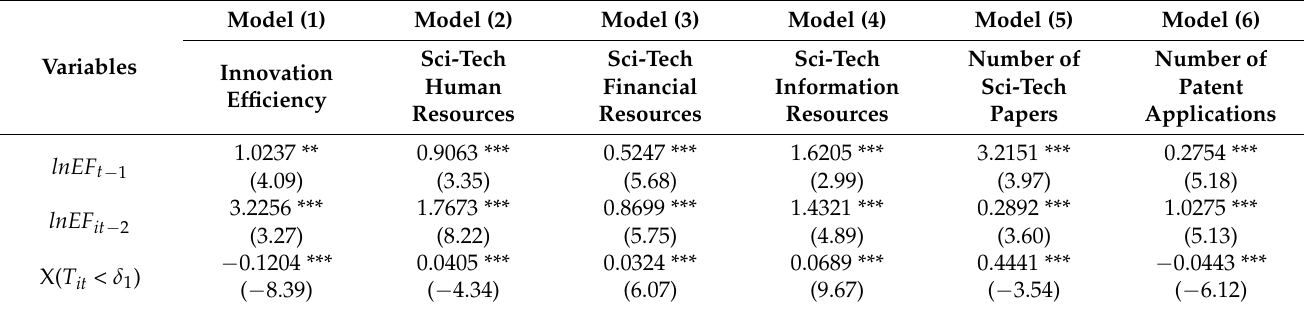
Table 4. Double-threshold model parameter estimation